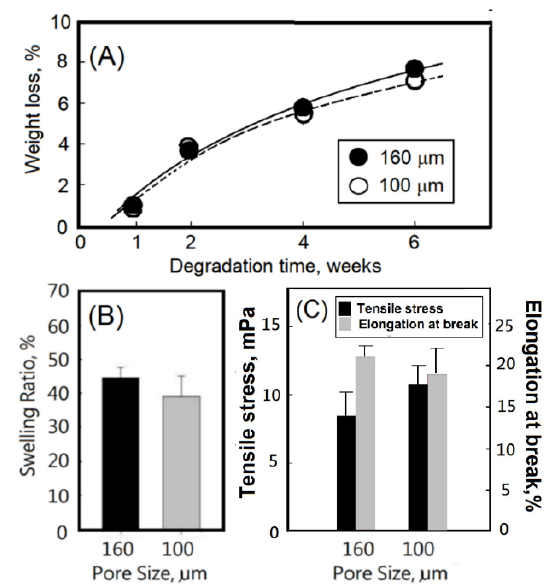
Figure 4. ( A ) Degradation rate, ( B ) swelling ratio, and ( C ) tensile strength and elongation at break of EDC-crosslinked gelatin-based hydrogel scaffolds with different pore sizes (160 and 100 μ m). Results were expressed as the means ± SEM (n = 3).